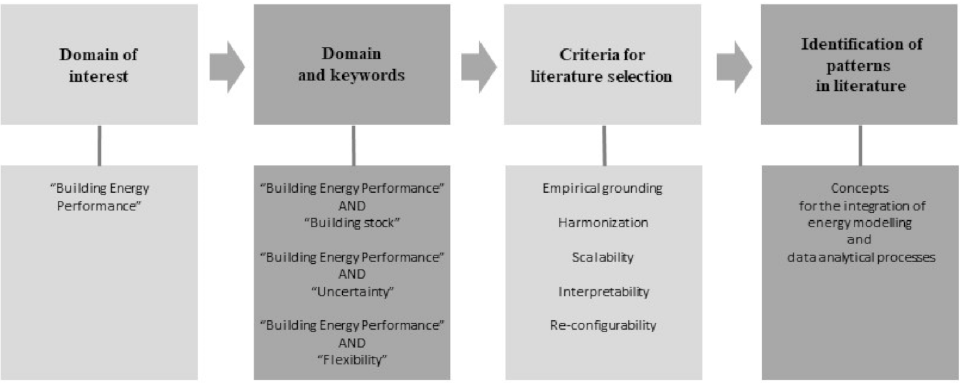
Figure 1. Diagram synthesizing the research